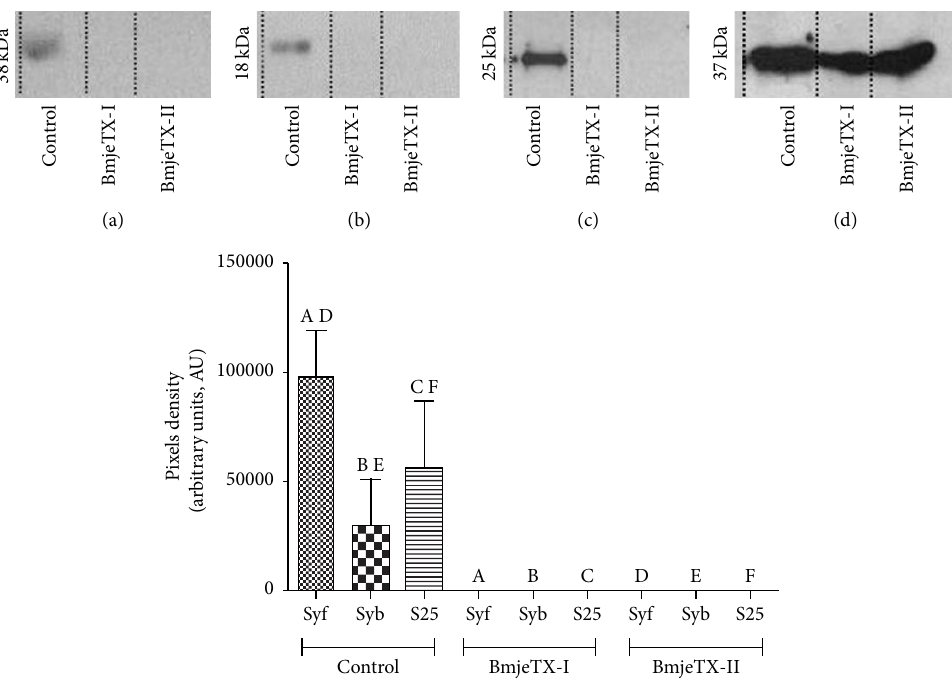
Figure7:Westernblottinganalysisforsynaptophysin((a),Syf),synaptobrevin((b),Syb),andSNAP25((c),S25)proteinexpressionincontrol, BmjeTX-I, and BmjeTX-II chick biventer cervicis preparations normalized to GAPDH (d). The bars with same uppercase letters indicate that there was significant difference: A , D 𝑝 < 0.001 ; C , F 𝑝 < 0.001 ; B , E 𝑝 < 0.05 . Data were expressed as mean ± SD; one-way ANOVA plus Bonferroni posttest ( 𝑛 = 4 per